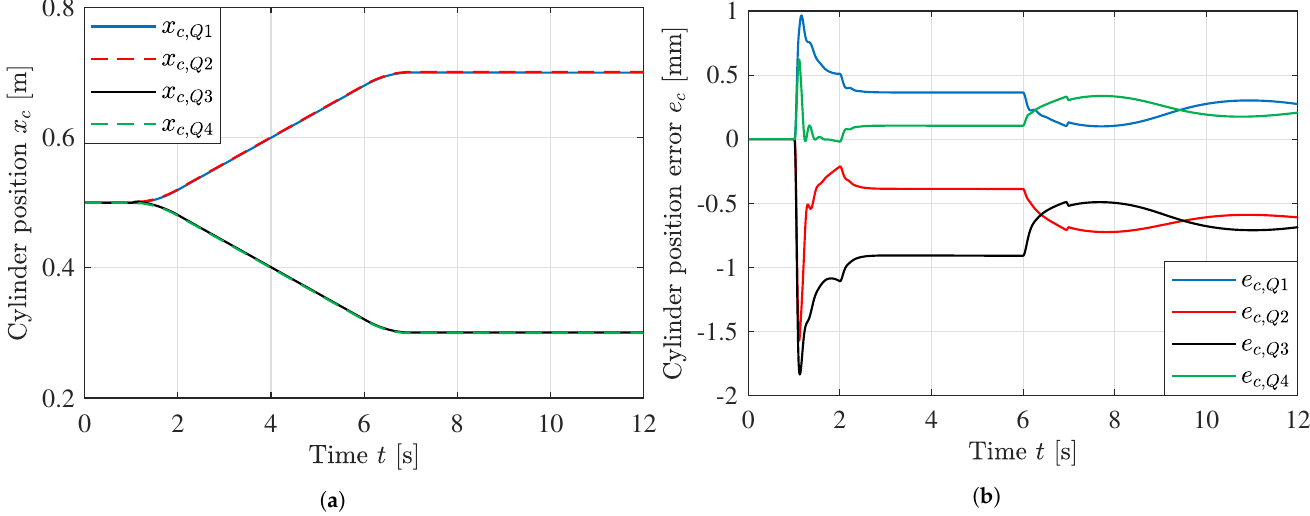
Figure 16. Cylinder position and position error for all four quadrants. ( a ) Cylinder position x c ; ( b ) Cylinder position error e c